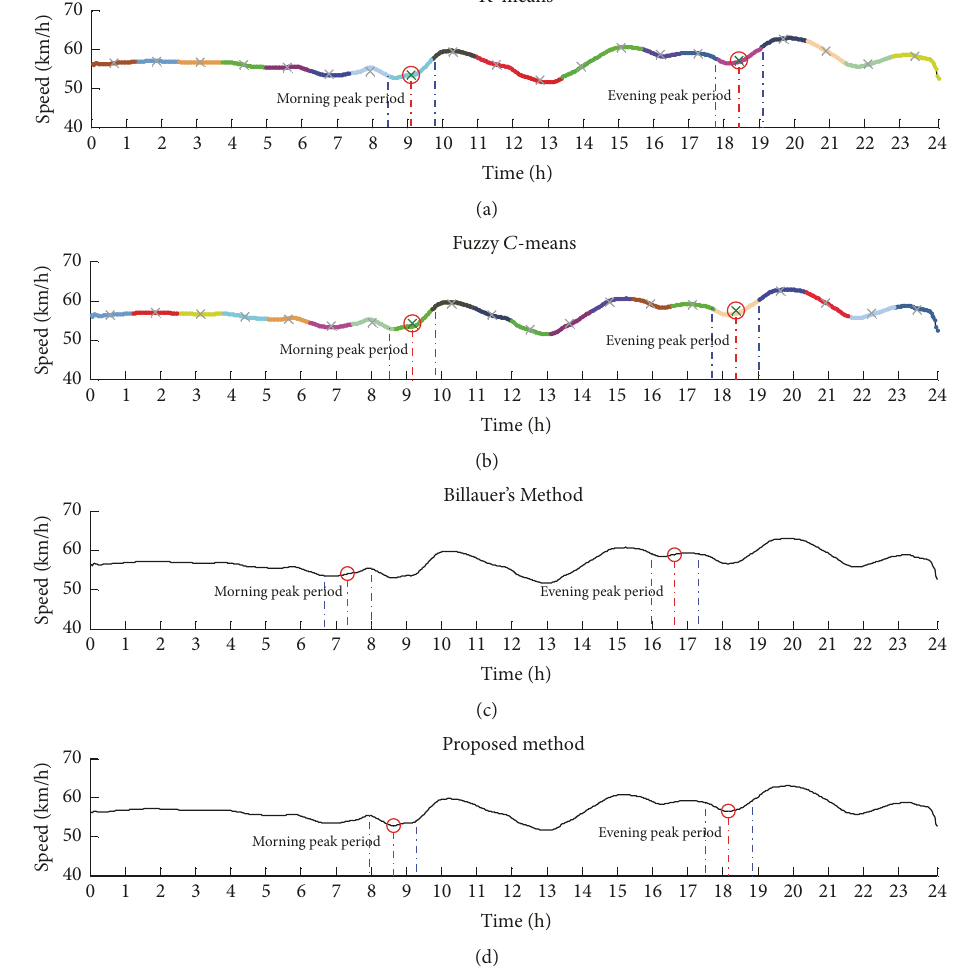
Figure 5: The detection results on Road